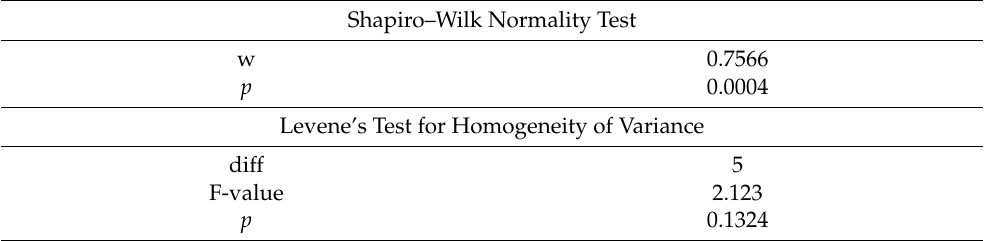
Table 12. Shapiro and Levene’s test result (KL).